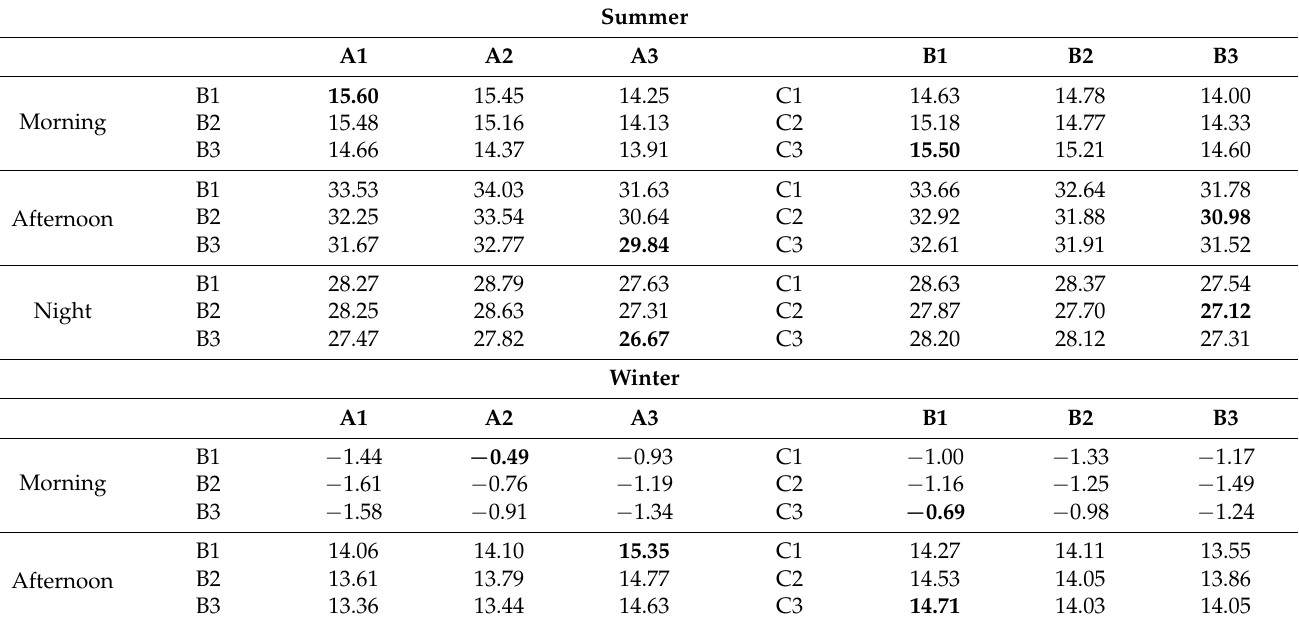
Table 10. Calculation of interactions between A and B as well as B and C in summer and